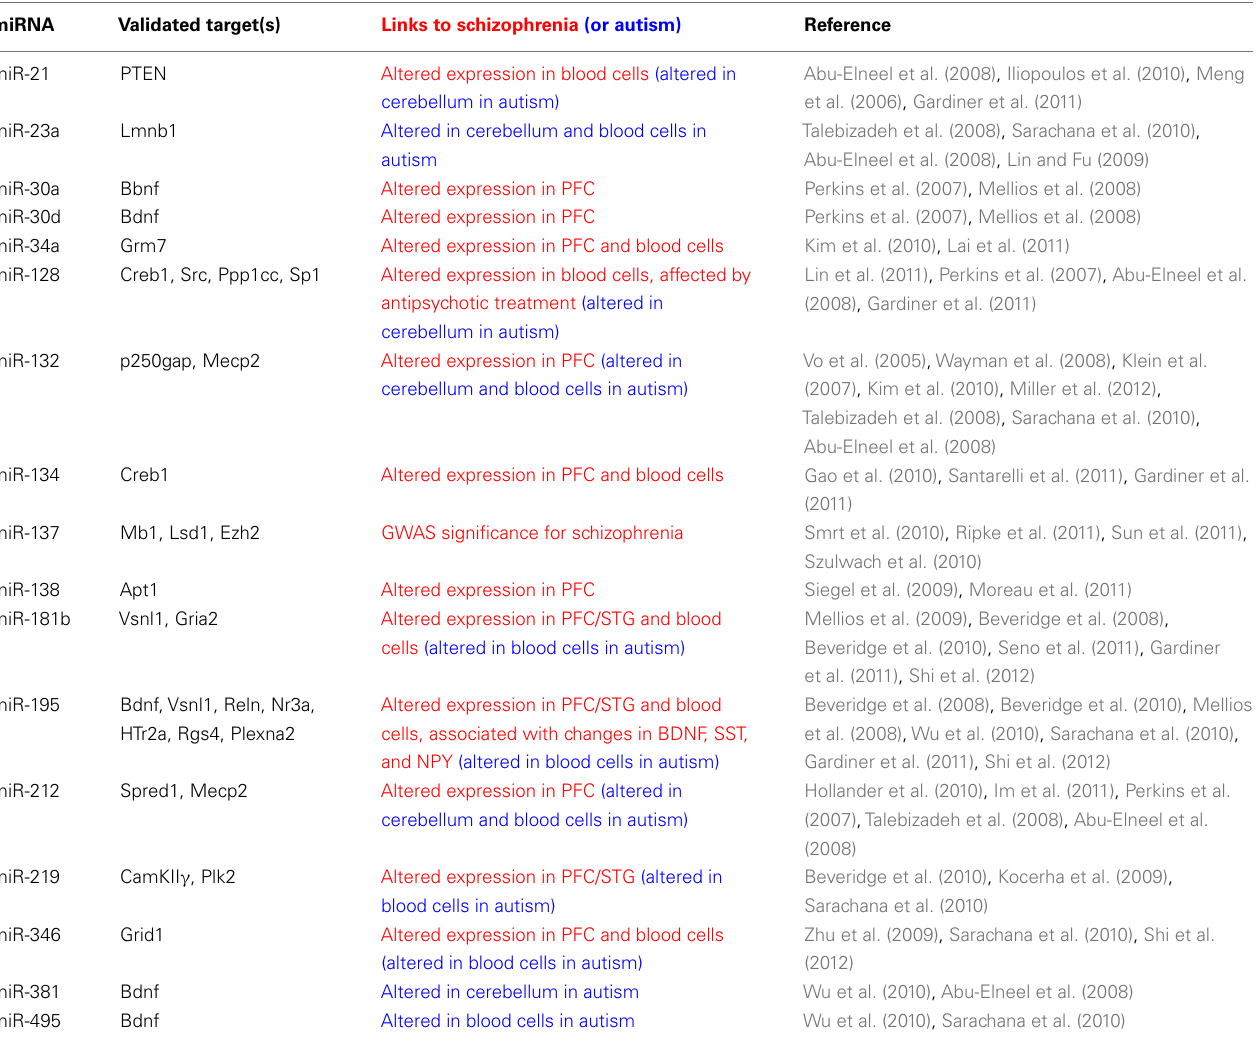
Table 1 | MicroRNAs involved in brain plasticity and maturation with links to schizophrenia and autism spectrum disorders.